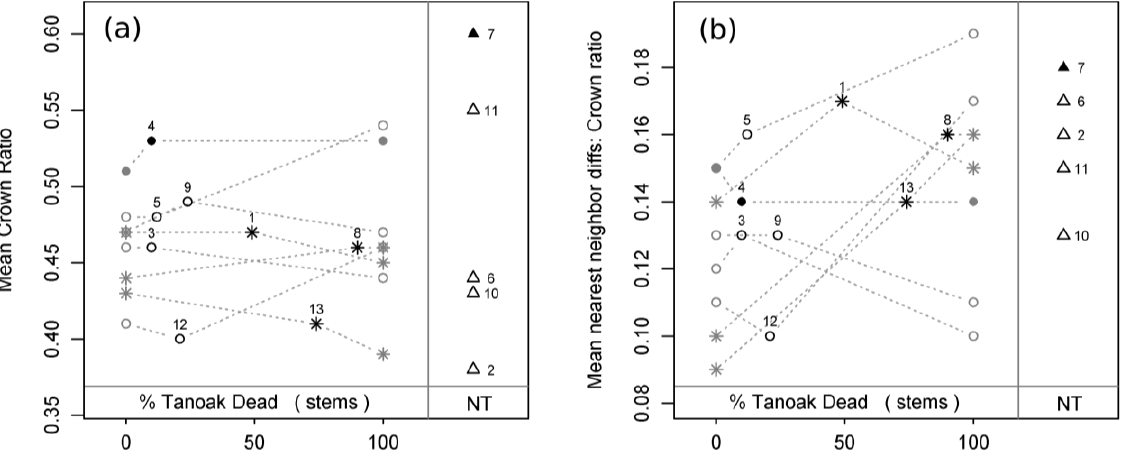
Figure 5. Mean crown ratio (a) and mean crown ratio difference between nearest neighbors (b) as a function of plot status and disease progression. Black numbered symbols represent present conditions of all 13 sampled plots: circles = healthy plots (H); stars = diseased plots (D), triangles = plots without tanoak (NT); open symbols = second growth plots; closed symbols = old growth plots. Grey symbols represent reconstructed pre-SOD conditions (0% tanoak dead) and projected future conditions (100% tanoak dead) for all plots with tanoak. Grey dotted lines connect each plot’s present condition to its respective pre-SOD and future conditions, thereby displaying predicted transitions for each plot. Plot ID numbers correspond to Table